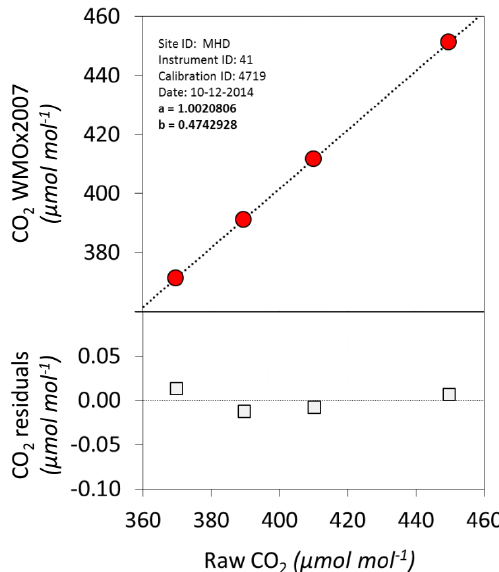
Figure 9. Linear fit of the CO 2 calibration detailed in Fig. 8. Coef- ficients a and b of the fit are shown in bold characters. The lower plot shows CO 2 residuals from the linear regression.